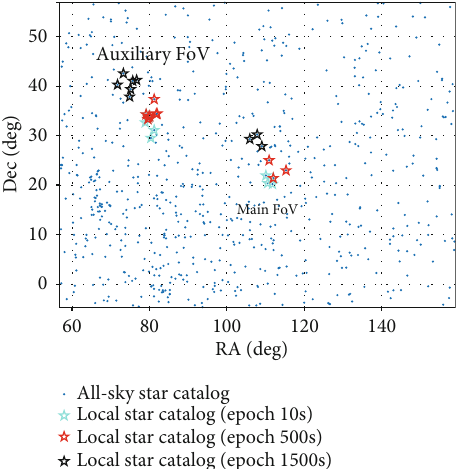
Figure 19: Number of successful matching for the whole trace.